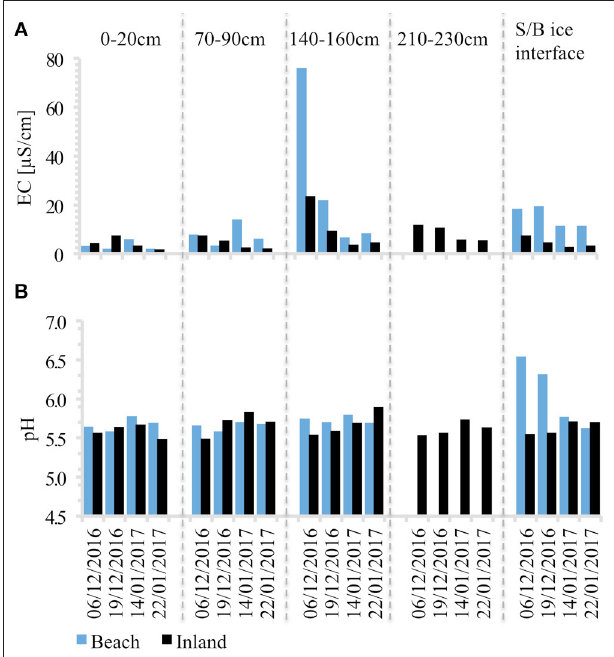
FIGURE 4 | (A) Electrical conductivity (EC); and (B) pH dynamics in the snowpack. Values are averaged from triplicate samples at each depth. S/B ice interface represents snow collected at depth 240–280cm at the beach site, and 260–280cm at the inland site. Standard deviations are shown in Table 1 . Note that snow was shallower at the beach (hence no data for